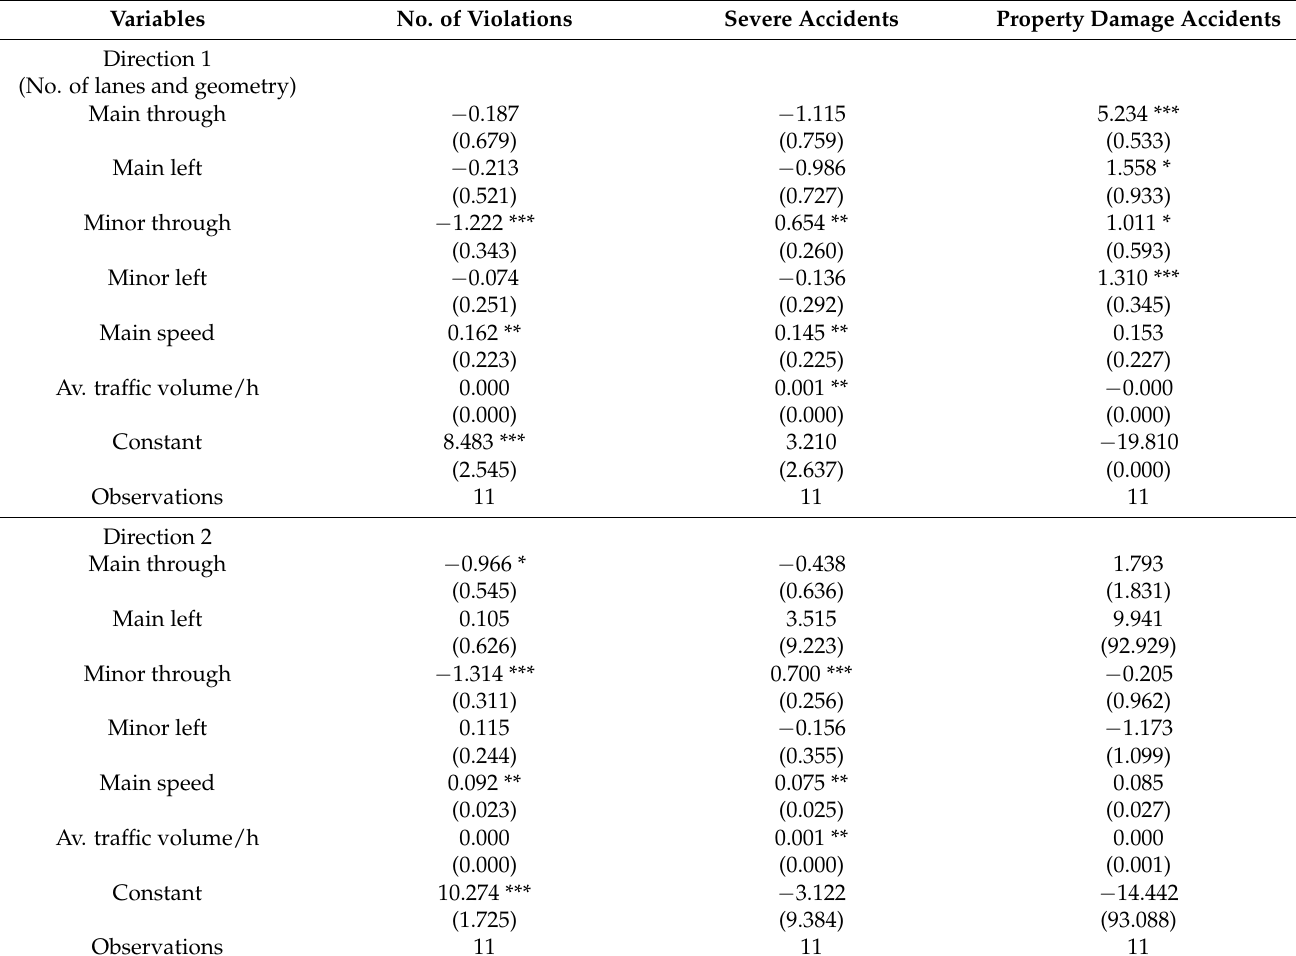
Table 3. Effect of geometric conditions on safety performance of three-leg